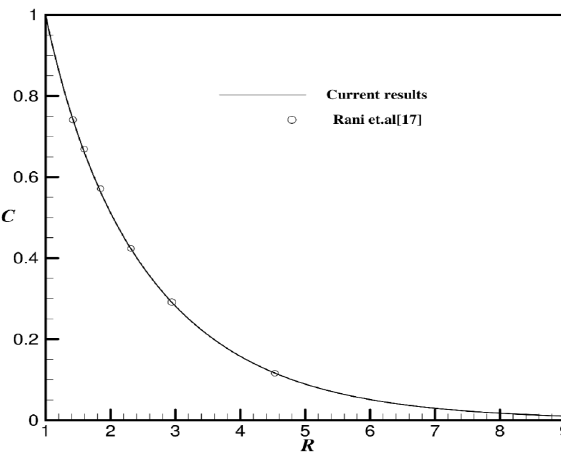
Figure 2: Validation of current results with the existed results of Rani et al. [17].